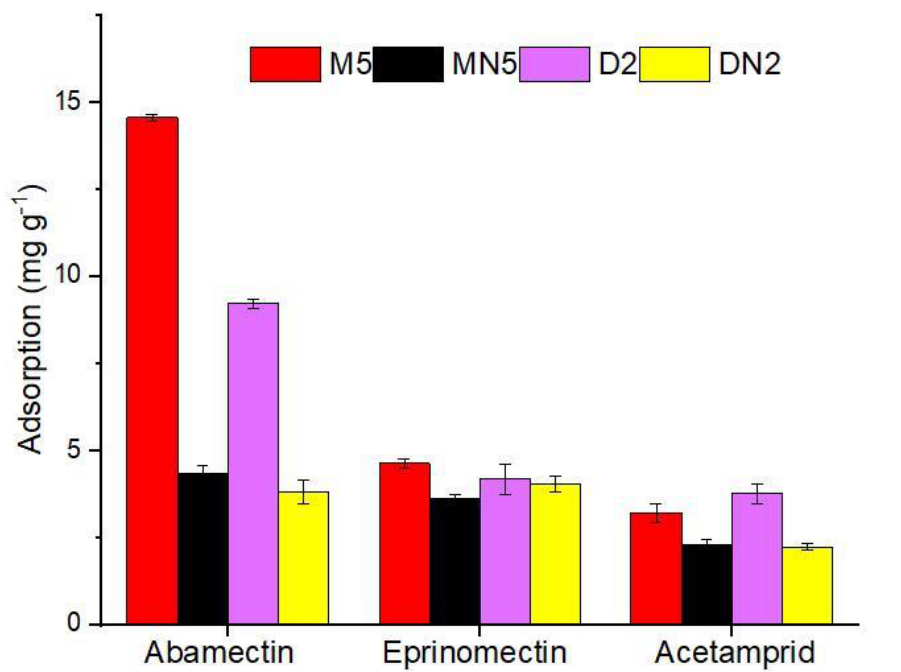
Figure 8. Selectivity parameters of polymers for ABM and its competitors. Table 4. Imprinting factors and selectivity coefficients of polymers for ABM and its competitors.